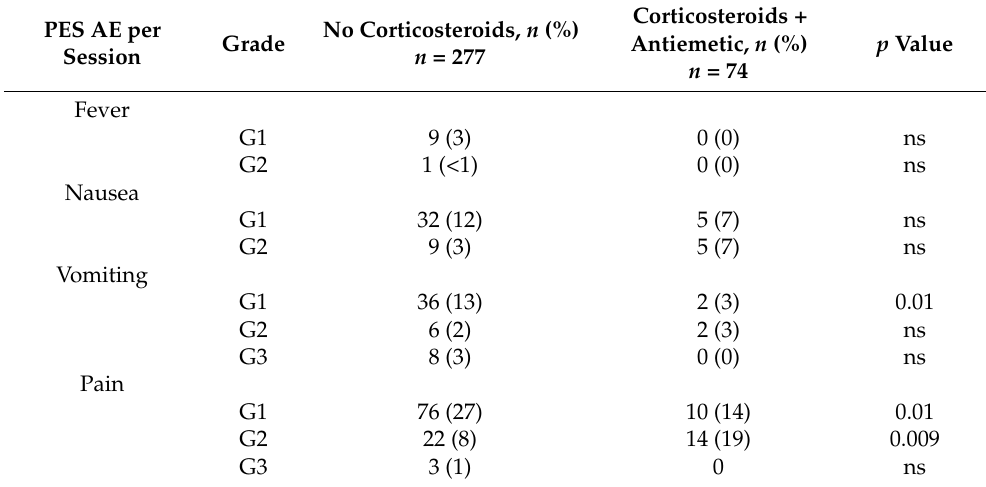
Figure 3. AE-BS of PES after the use different procedural medications. Boxplots of PES AE-BS as the sum of all PES AE grades per patient shown for different groups of procedural medications used per session. “+” indicates the use of the respective medication, “+/ − ” indicates the use for some but not all sessions in that group. The number of total sessions the number of sessions with at least ≥ 1 PES AE (percentage per group), as well as the number of sessions with at least 0 PES AE (percentage per group) and the number of different centres per group are listed. Statistically significant differences in the medians between all groups were assessed using the Kruskal-Wallis-Test. Table 5. PES AEs per session in absence of corticosteroid use compared to sessions with corticosteroid use. Data is presented as counts and percentages. Significant differences between categorical data were assessed using Chi-squared test ( p values ≤ 0.05 were considered